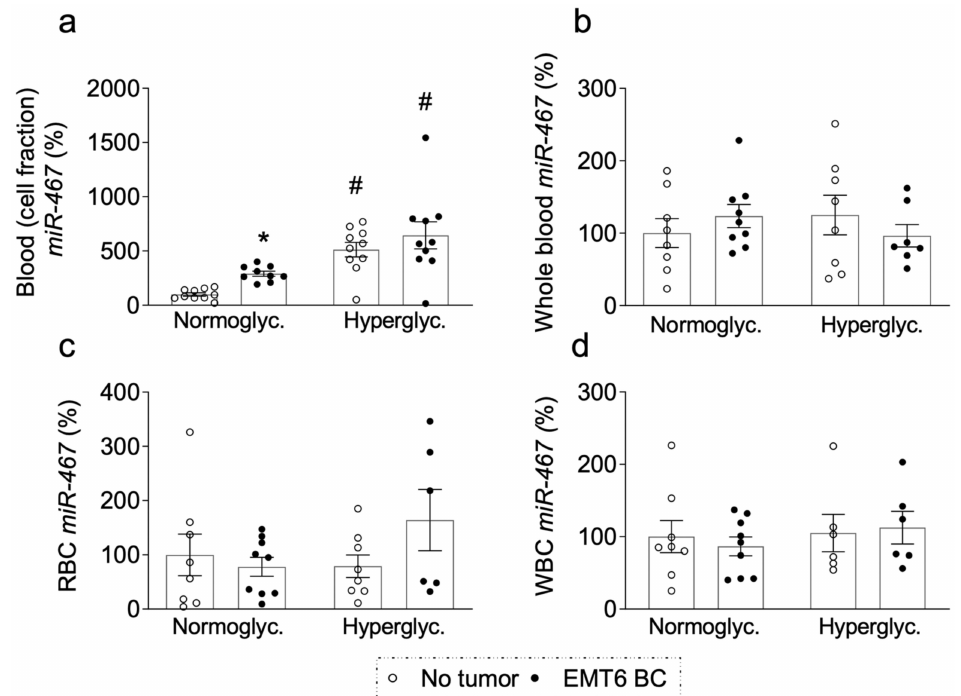
Figure 6. MiR-467 expression in blood of hyperglycemic mice on Western diet. ( a ). miR-467 levels were analyzed in cellular fraction of blood from normoglycemic and hyperglycemic mice with tumors (closed circles) and without tumors (open circles). ( b ). miR-467 levels were analyzed in whole blood from normoglycemic and hyperglycemic mice with tumors (closed circles) and without tumors (open circles). ( c ). miR-467 levels were analyzed in red blood cells (RBC) from normoglycemic and hyperglycemic mice with tumors (closed circles) and without tumors (open circles). ( d ). miR-467 levels were analyzed in white blood cells (WBC) from normoglycemic and hyperglycemic mice with tumors (closed circles) and without tumors (open circles). Bars represent the mean ± SEM, RT-qPCR. * p < 0.05 comparing to no tumor. # p < 0.05 comparing normoglycemic controls.